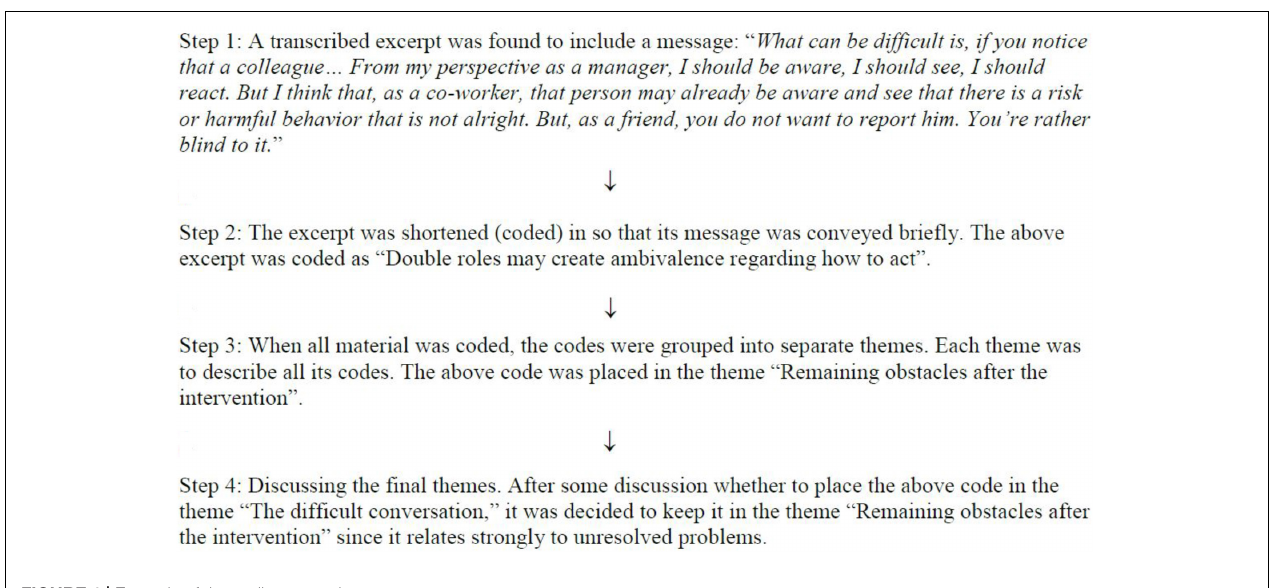
FIGURE 1 | Example of the coding procedure.